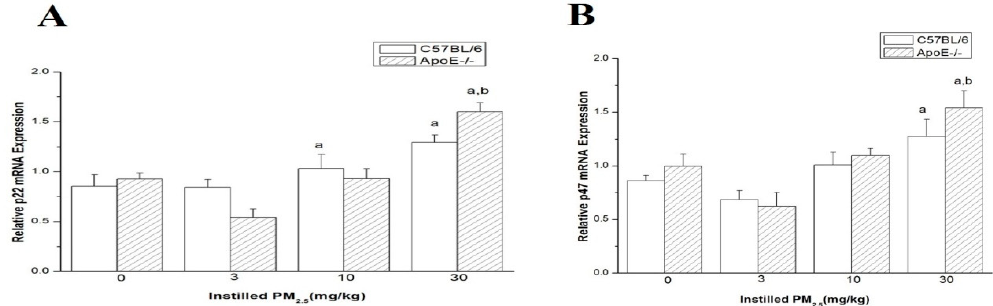
Figure 5. The mRNA expression of p22phox and p47phox in myocardium of mice after exposed to PM 2.5 . ( A ) represents the relative p22phox mRNA expression in mice; ( B ) represents the relative p47phox mRNA expression in mice. The doses were 0.0 (control), 3, 10, and 30 mg/kg b.w. Significant difference ( a p < 0.05) between PM 2.5 group and the control group, and significant difference ( b p < 0.05) between C57BL/6 and dose- matched ApoE − / − mice were observed.